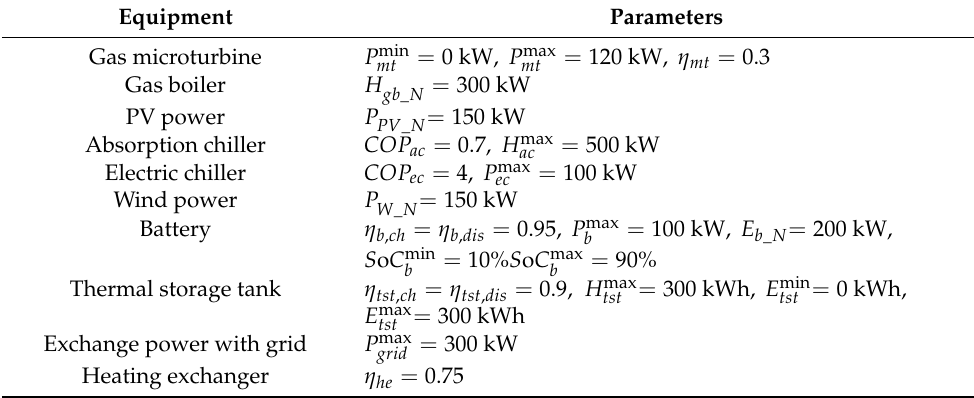
Table 1. Equipment Parameters in the Integrated Energy